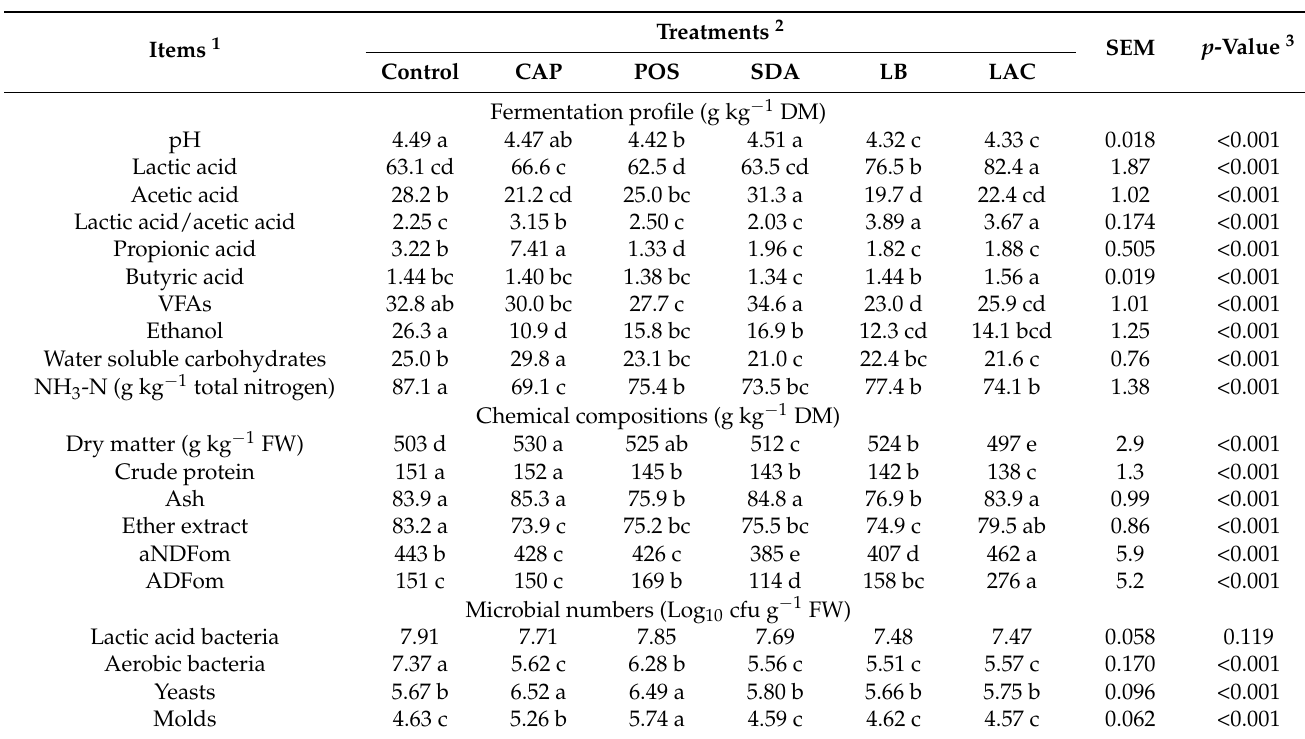
Table 3. Fermentation profile, microbial and chemical compositions of total mixed ration silage after 95 days of